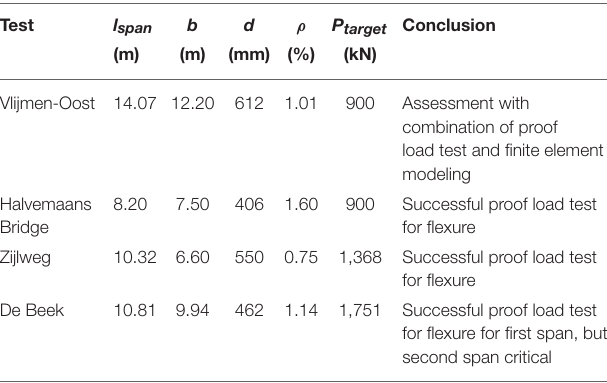
TABLE 6 | Overview of properties of pilot proof load tests for